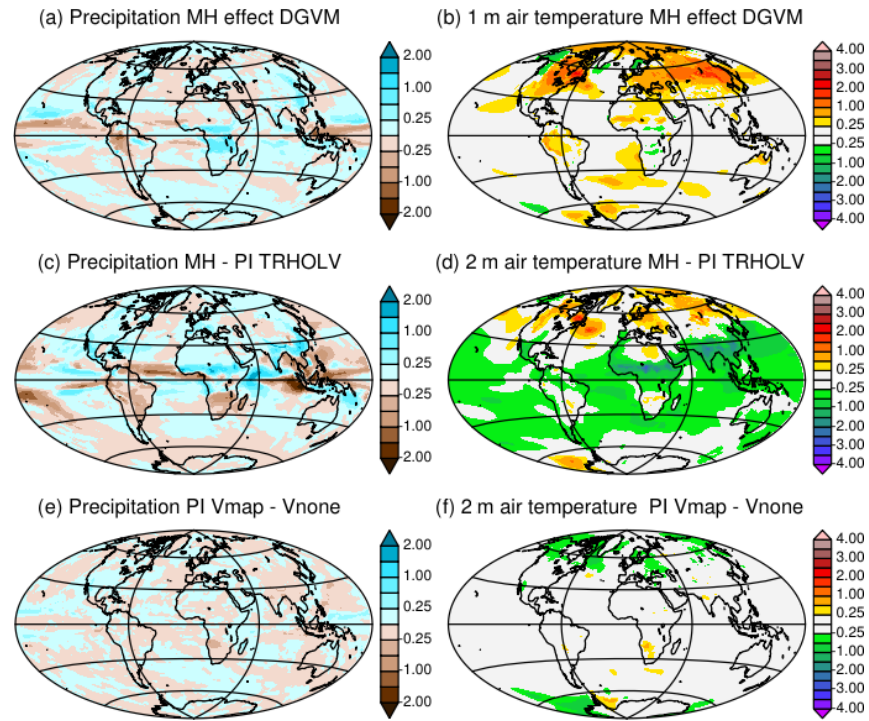
Figure 15. Impact of the dynamical vegetation and initialization of vegetation on the simulated climate. Differences for annual mean (a, c, e) precipitation (mmd − 1 ) and (b, d, f) 2m air temperature ( ◦ C) between (a) the MH in the TRHOLV simulation and (b) the MH simulation without dynamical vegetation (MH FPMIP4), (c) the Mid-Holocene and (d) the preindustrial simulations in the TRHOLV simulation, and (e) and (f) the two preindustrial simulations initialized from bare soil (PI-Vnone) or a vegetation map for vegetation (PI-Vmap). See Table 2 and text for details on the